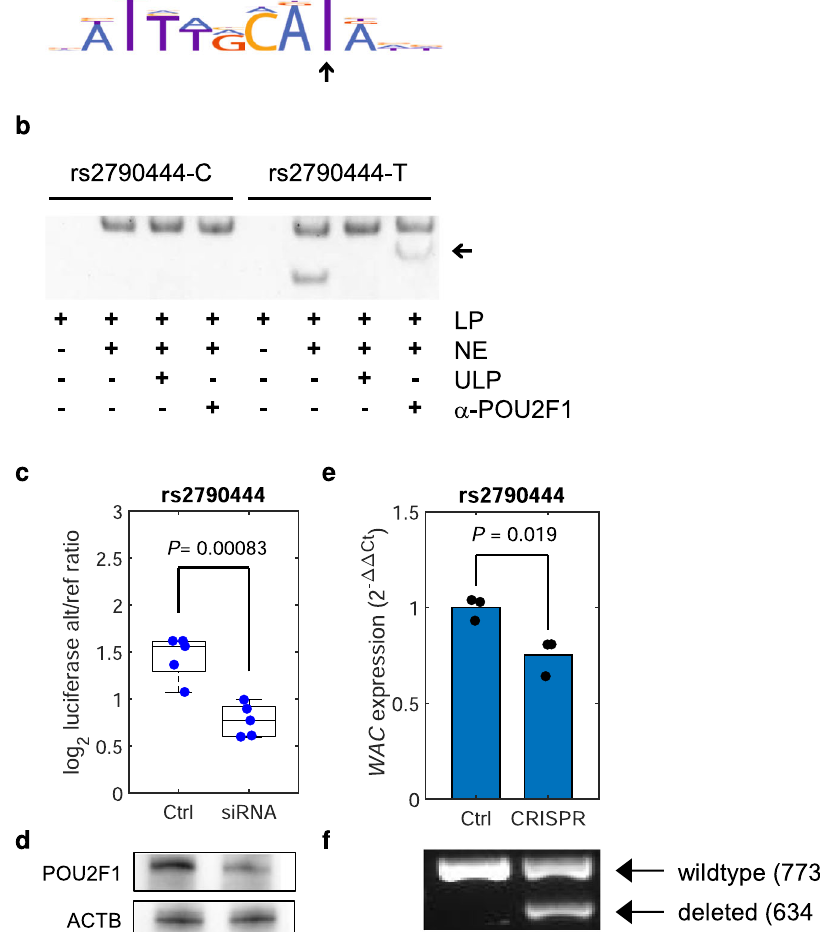
POU2F1. Arrow indicates the altered recognition base. b Electromobility shift assay showing selective binding of POU2F1 to rs2790444-T probe. Arrow indicates supershift with an antibody towards POU2F1. c siRNA-knockdown of POU2F1 attenuated luciferase activity for rs2790444-T relative to rs2790444-C in L363 cells. The y -axis indicates the log 2 ratio of the luciferase/renilla signal for rs2790444-T relative to the rs2790444-C construct. The bottom, middle, and top of each box plot represent the 25th, 50th, and 75th percentiles. The whiskers represent the non-outlier minimum and maximum values, located at 1.5 times the interquartile range from the bottom and top of the box, respectively. d Western blot con fi rming knockdown. e Quantitative PCR showing expression of WAC relative to control in MOLP8 cells upon dual-sgRNA CRISPR/Cas9 deletion of a 139-bp region harboring rs2790444, heterozygous for rs2790444. Blue bars indicate the averages of the individual measurements. f Agarose gel con fi rming deletion of the targeted region.